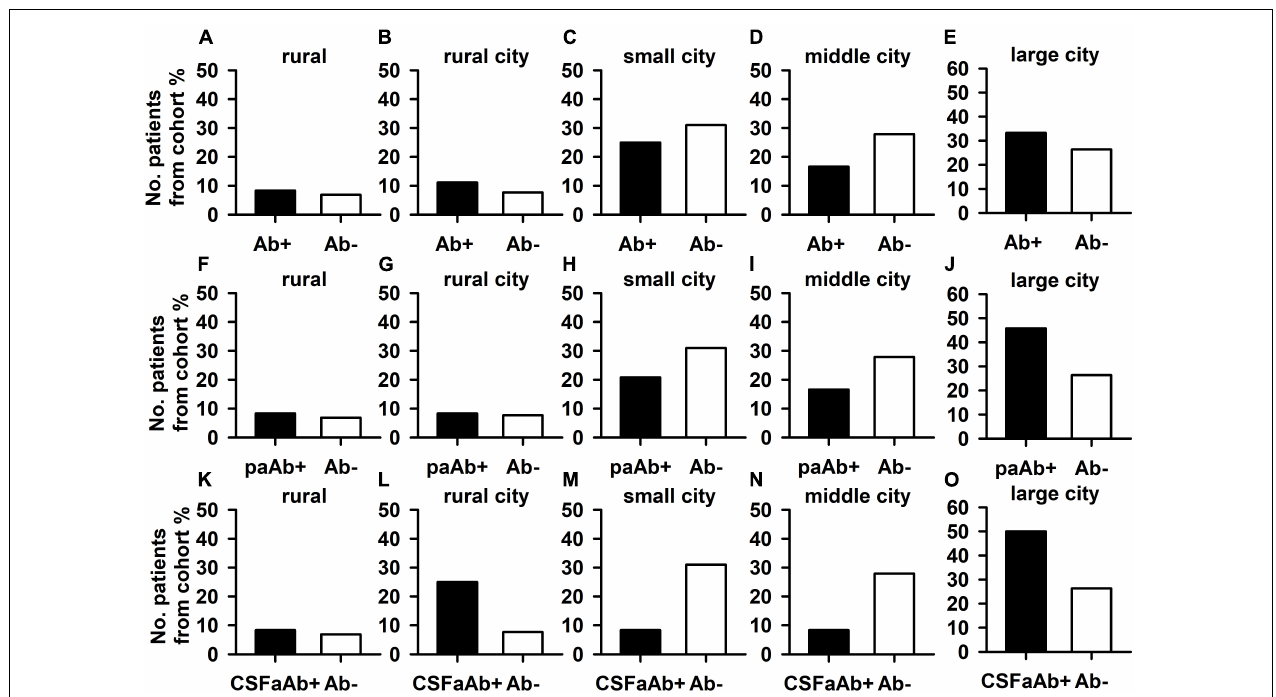
FIGURE 3 | Psychiatric patients with and without neural autoantibodies in different dimensions of an urban and rural environment. The percentages of psychiatric patients with neural autoantibodies (Ab+) did not differ from those without neural autoantibodies in all dimensions: rural (less than 2,000 inhabitants) (A) , rural town (2,000–5,000 inhabitants) (B) , small city (5,000–20,000 inhabitants) (C) , middle city (20,000–100,000 inhabitants as a medium-sized city), (D) and large city (over 100,000 inhabitants a large city) (E) . Furthermore, the percentage of psychiatric patients with neural autoantibodies and a probable or definitive autoimmune origin (paAb+) did not differ from the percentage of those without neural autoantibodies in all dimensions: rural (F) , rural town (G) , small city (H) , middle city (I) , and large city (J) . Finally, also the percentages of psychiatric patients with CSF neural autoantibodies (CSFaAb+) did not differ from those of patients without neural autoantibodies in all dimensions: rural (K) , rural town (L) , small city (M) , middle city (N) , and large city (O) . Ab+, neural autoantibody positive, Ab-, neural autoantibody